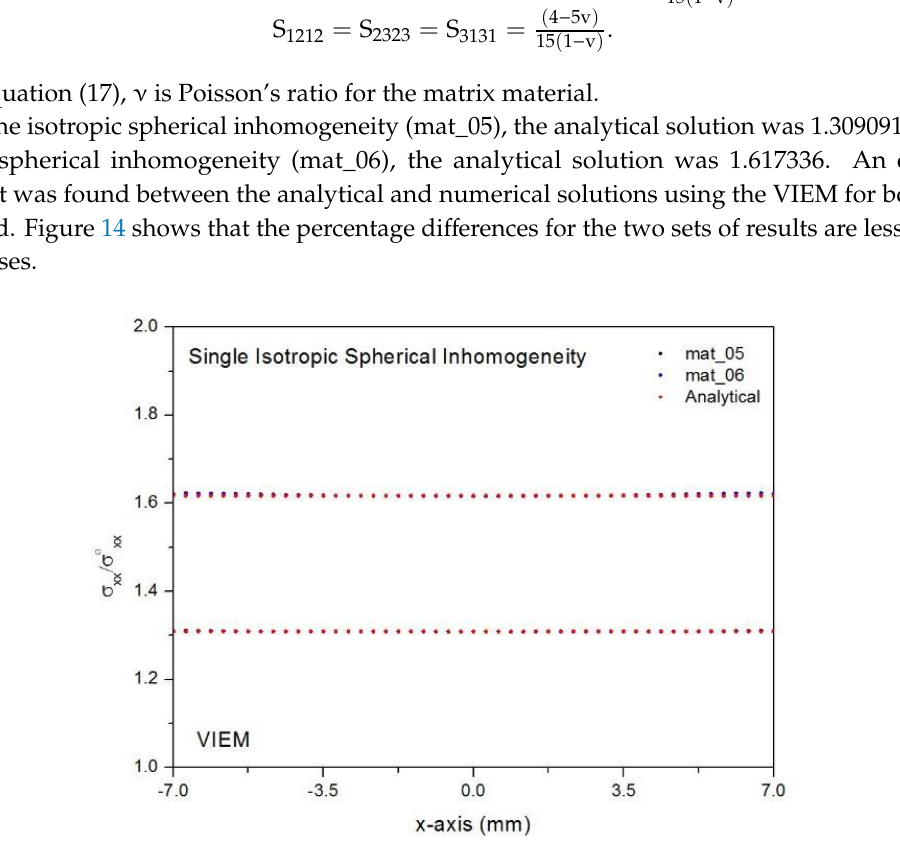
Figure 14. Comparison of the numerical results using the volume integral equation method (VIEM) and the analytical solutions for the normalized tensile stress component (σ xx /σ oxx ) along the x-axis inside the isotropic spherical inclusions with a radius of 7 mm under uniform remote tensile loading.